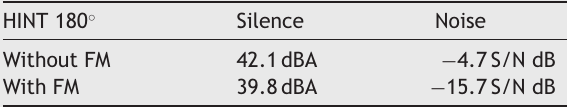
Results of the hearing in noise